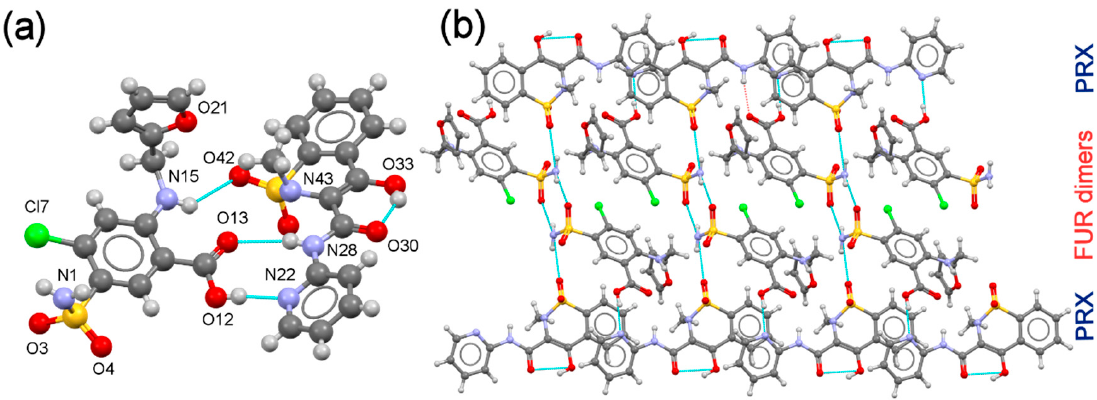
solvate structure and the corresponding reactants.